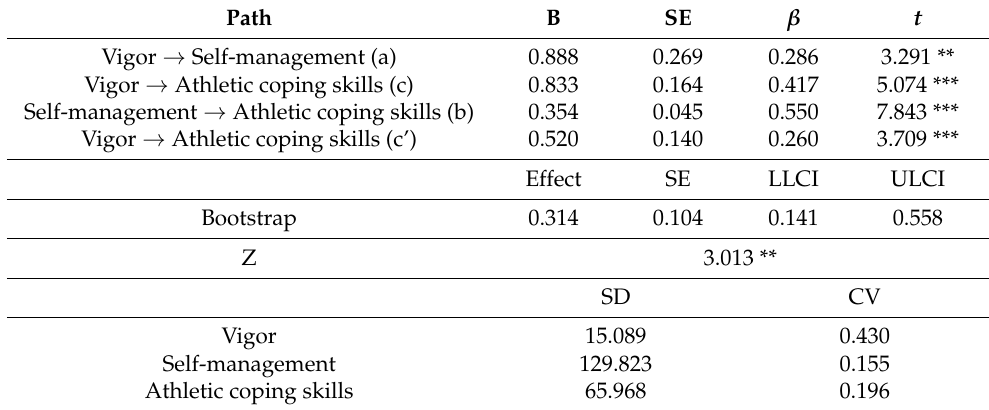
Table 6. The mediated effect wherein vigor affects sports coping skills through self-management. Path